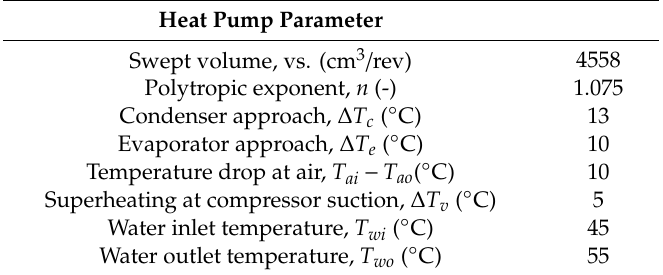
Table 4. Main parameters of the heat pump calculated in the design point and set as constant in o ff -design